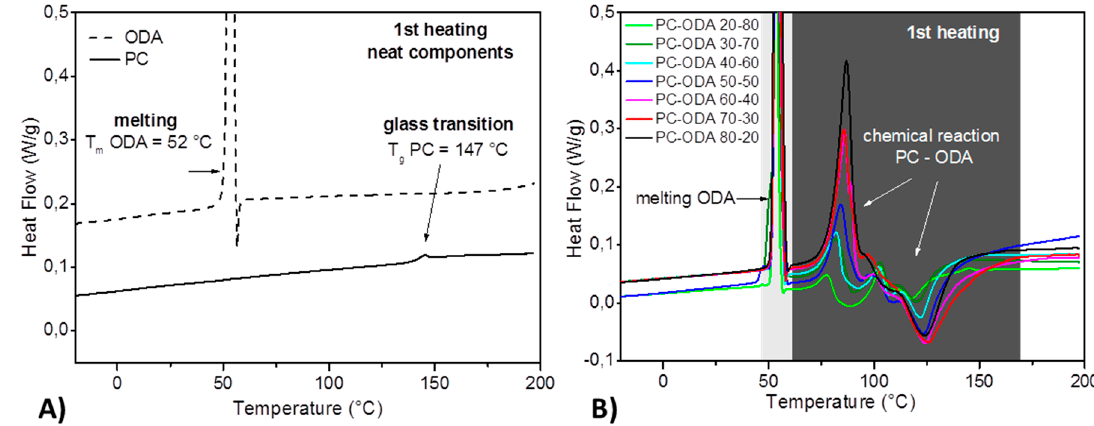
Figure 7. ( A ) DSC curves of neat ODA and neat PC. ( B ) DSC curves of seven mixtures from PC and ODA with mass ratios PC/ODA, as denoted in the legend.